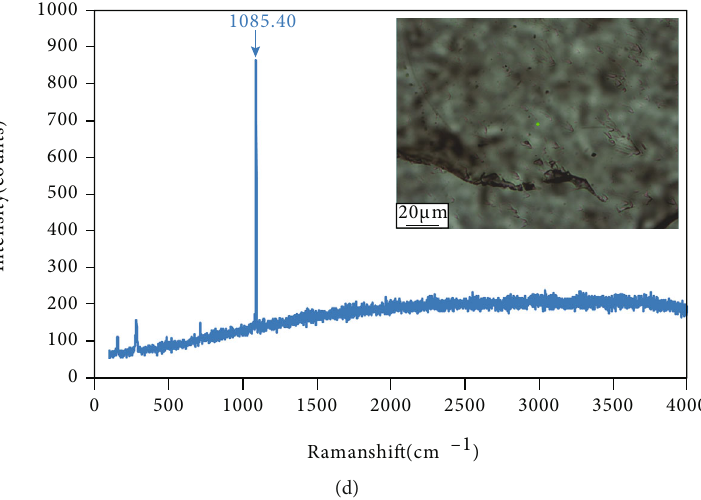
Figure 7: Raman spectra of host minerals in the J